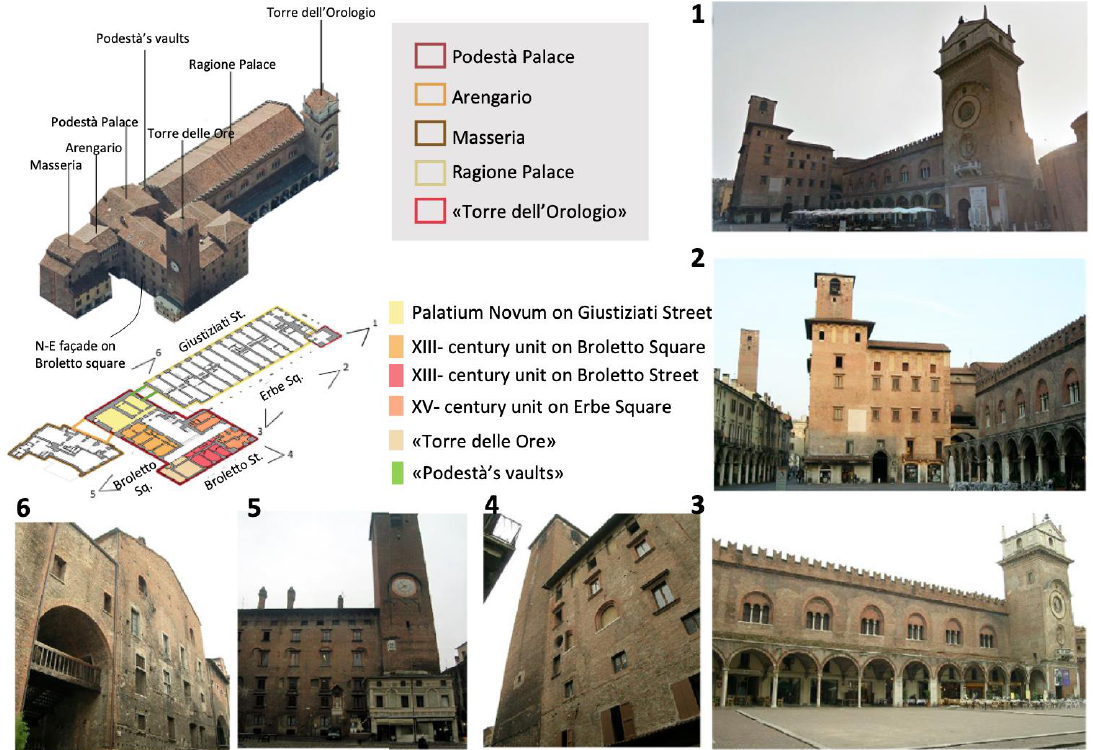
Figure 2. Overview of the different units of the